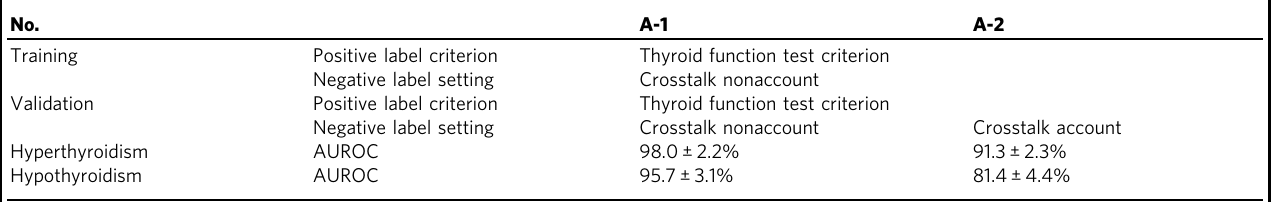
The mean and standard deviation for the tenfold cross-validation are shown for the AUROC scores. “ Crosstalk account ” represents the negative label setting, where both the control group and the hypothyroidism group were labeled negative in the hyperthyroidism group and both the control group and the hyperthyroidism group were labeled negative in the hypothyroidism group. “ Crosstalk nonaccount ” represents the negative label setting where only the control group was labeled